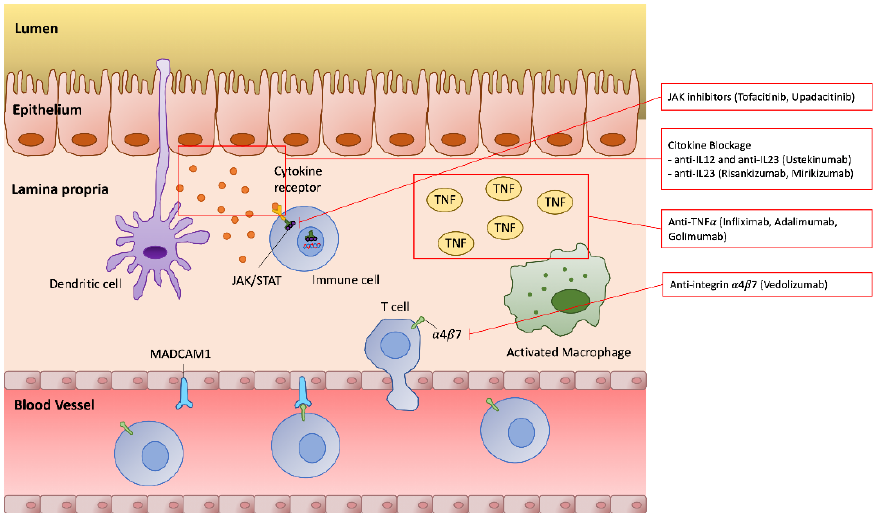
Figure 1. Mechanisms of action and targets of current biologic therapies in IBD.